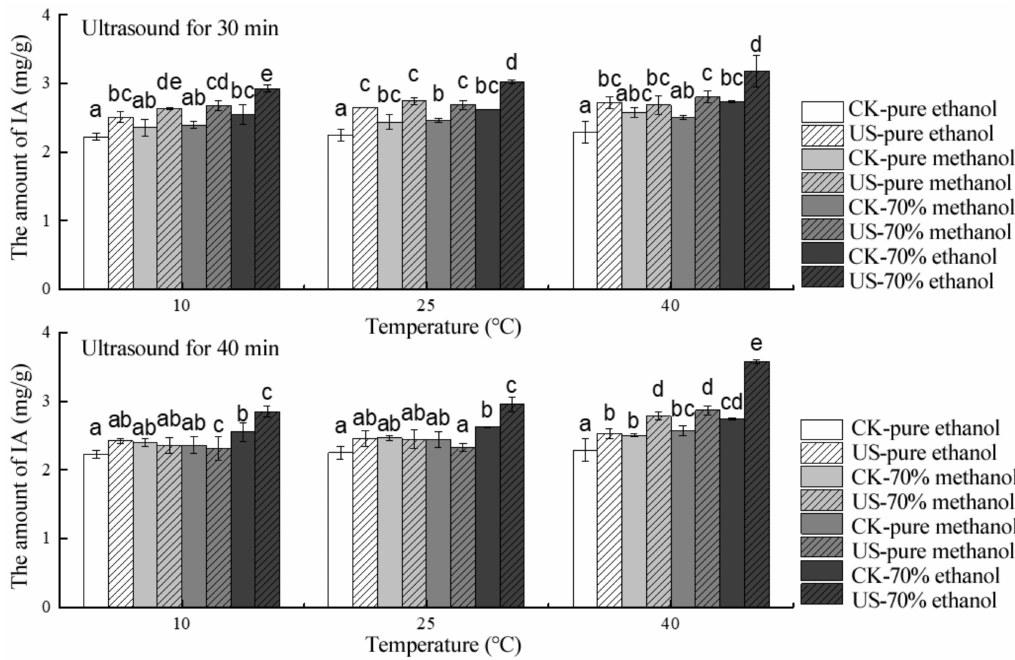
Figure 4. E ff ect of solvent on the stability of individual anthocyanin in blueberry pomace under ultrasound treatment and conventional solvent extraction. Di ff erent letters on bars show significant di ff erences ( p <